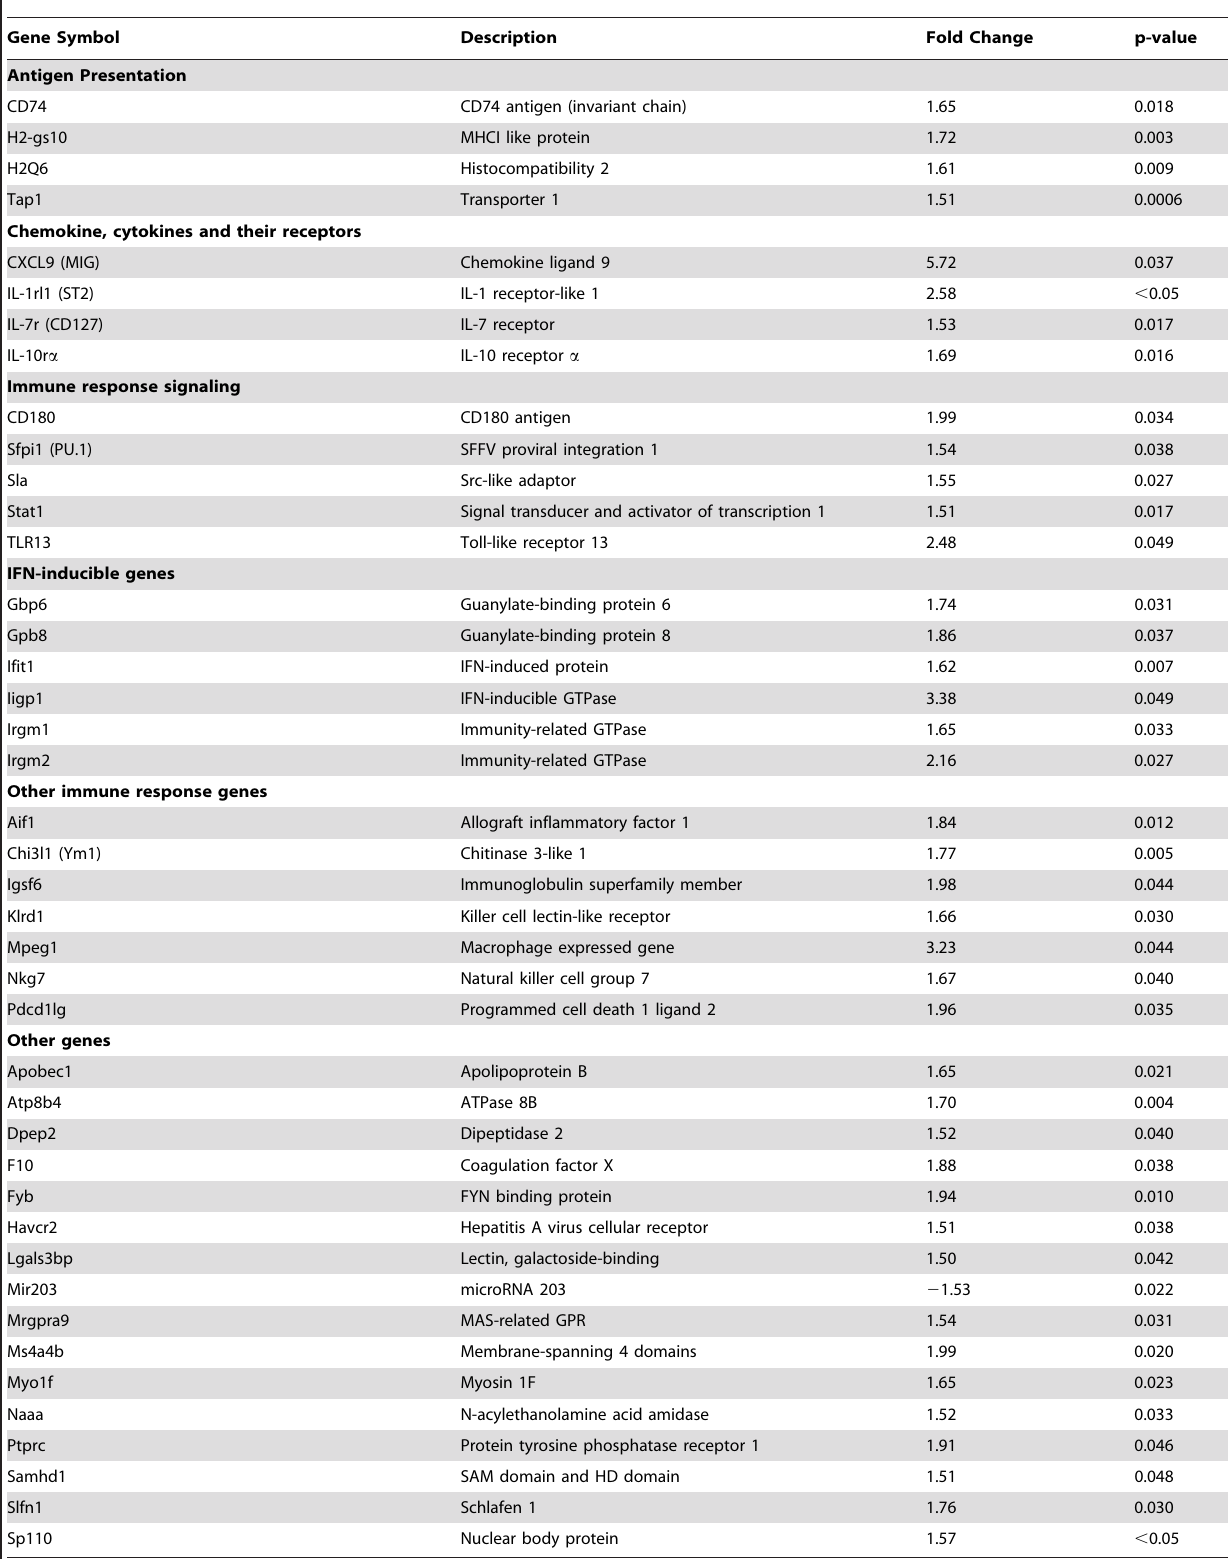
Table 1. Genes differentially expressed in response to SGS